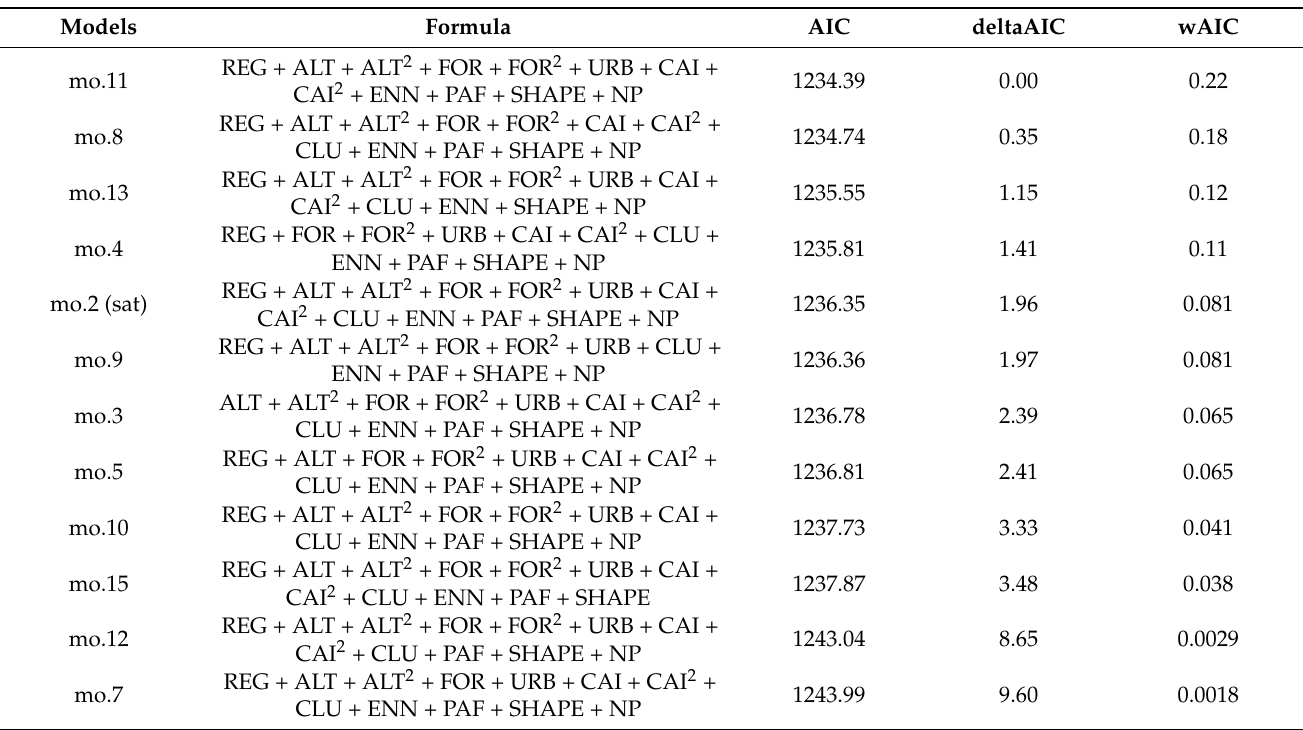
Table A3. Landscape-scale model selection. In the columns on the right, the AIC, deltaAIC, and AIC weights (wAIC; used for calculating the RVI index) for each model are shown. No detectability variables were used at this scale: